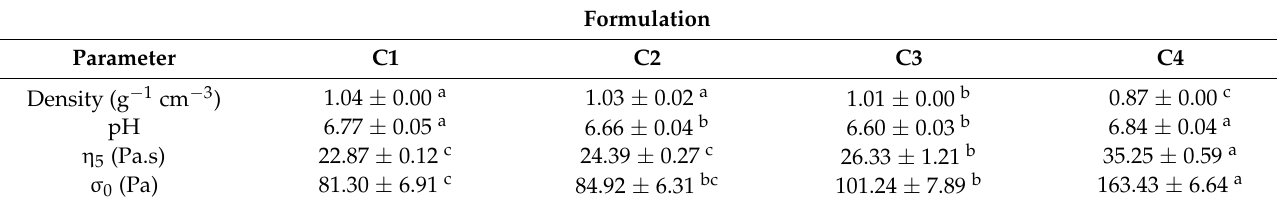
Table 2. Density, pH, rheological parameters of apparent viscosity ( η ) at a shear rate of 5 ( η 5 ), and the initial shear stress ( σ 0 ) as determined by steady-shear tests, the storage (G’ LVR ) and loss (G” LVR ) moduli at the linear viscoelastic region (LVR), the limiting value of oscillatory stress (OS L ), the loss-tangent (tan δ LVR ) at the LVR, the flow-point oscillatory stress (FP OS ), and the flow-point G (FP G ) as determined by stress sweep tests (at a 1 Hz frequency) for the batters prepared with different fat types measured at 25 ◦